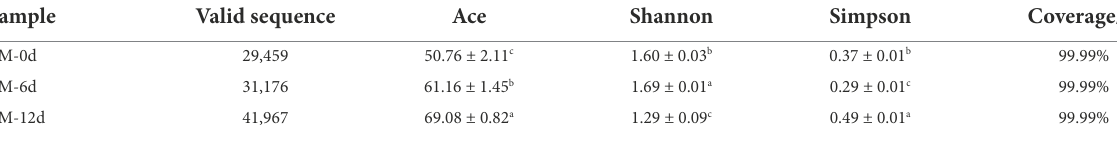
TABLE 1 Alpha-diversity of bacterial community in fermented sausage during ripening process. Sample